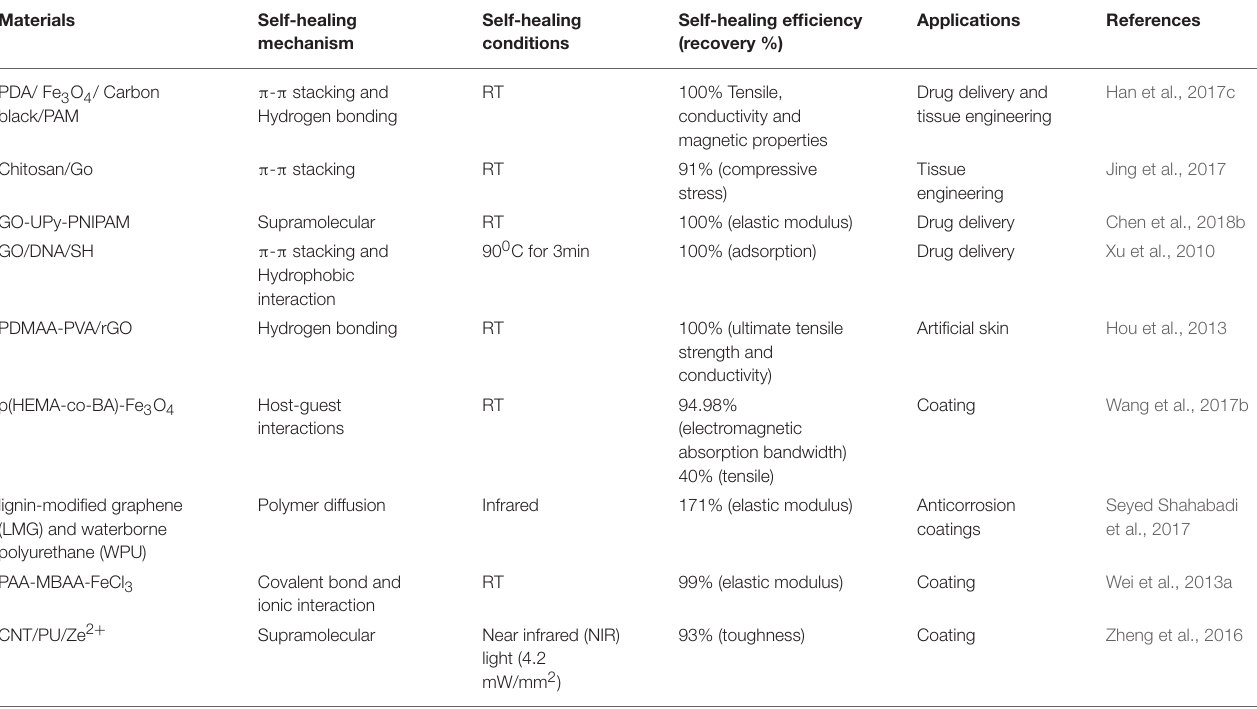
( Figure 5 ) (Fuhrmann et al., 2016). In general, the common dynamic chemical interactions based self-healing are reversible upon temperature usage, thus limiting their application